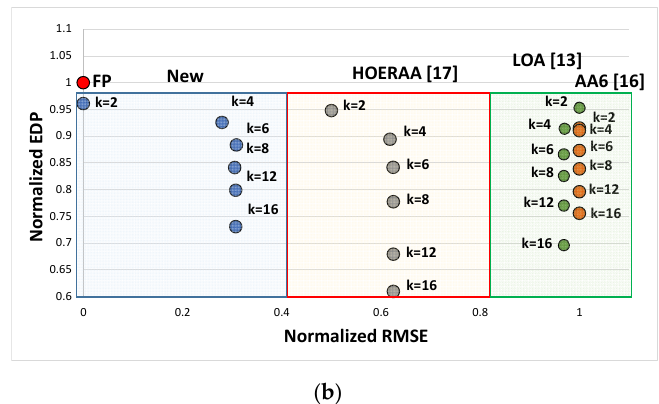
Figure 7. Normalized Energy-Delay-Quality trade-off: ( a ) EDP versus MED; ( b ) EDP versus RMSE.